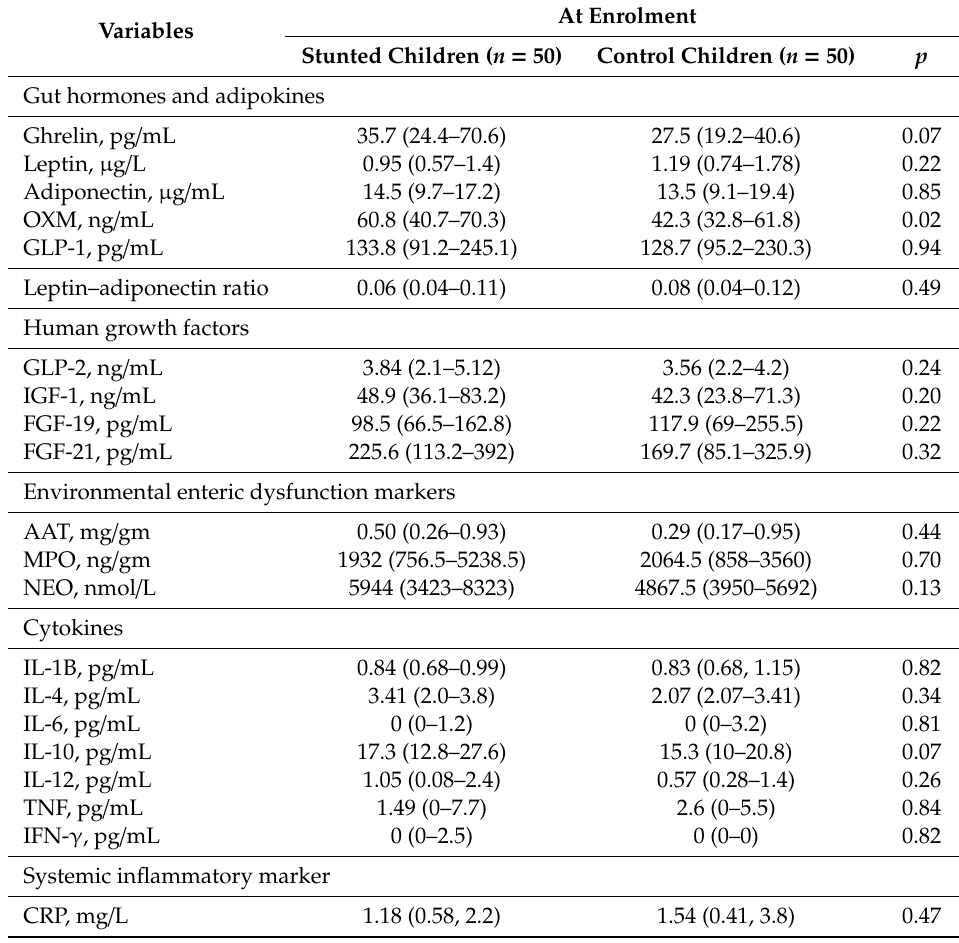
Table 2. The di ff erence in di ff erent biomarkers levels at enrolment between stunted and control